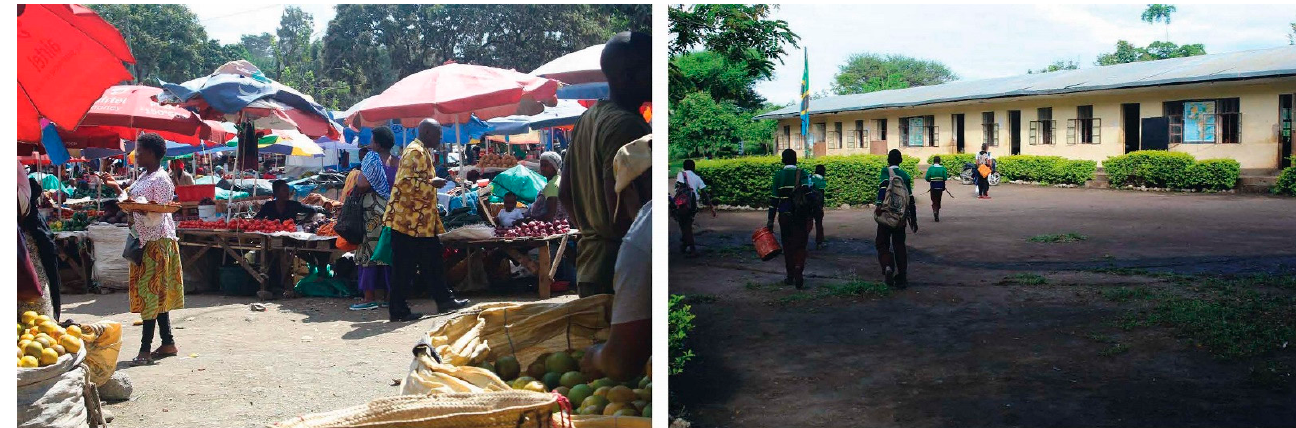
Figure 1. A typical marketplace and a typical school in Arusha, Tanzania. The poverty rate in Arusha is 48.4%, with 17.1% of the population living in extreme poverty. Only half (49.6%) of the population have improved sanitation facilities with flush toilets or improved latrines, and a majority (60.5%) rely on firewood for cooking instead of electricity. As of 2017, 78% of Tanzanian households owned a mobile phone, and this percentage has been growing [28]. In Tanzania, pre ‐ primary education is available, but not mandatory. Out of all chil ‐ dren in the Arusha region in the relevant age range, less than half were enrolled in pre ‐ primary school in 2018 (net enrollment ratio = 47.7%) [29].Countrywide, there are concerns about the quality of pre ‐ primary education. Most teachers lack formal training and often must manage extremely large numbers of students with few resources. According to UNICEF, in Tanzania, the student ‐ to ‐ qualified ‐ teacher ratio at the pre ‐ primary education level is 131:1. This ratio is 24:1 in private schools and 169:1 in public schools [30]. Figure 2 offers images of the pre ‐ primary schools where the research team worked. Figure 2. Pre ‐ primary schools in Arusha, Tanzania. For this study, the team recruited 10 public schools based on previous relationships with government and educational administrators in the region. All parents of children aged 5 or 6 years received written and oral information about the study. Parents provided active consent, but data collection was conducted with just 40 children, randomly selected from those who supplied parental consent. However, all children in the community were allowed to come to the screenings.